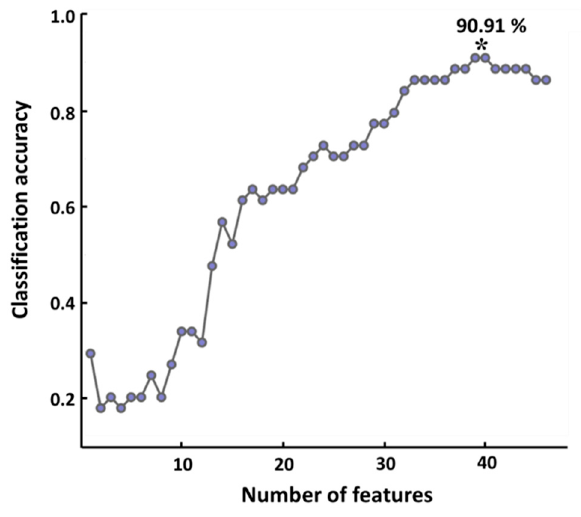
Figure 4. Classification accuracy with respect to the number of features. The maximum classification accuracy of 90.91% was obtained when using 39 features, which is denoted by an asterisk.